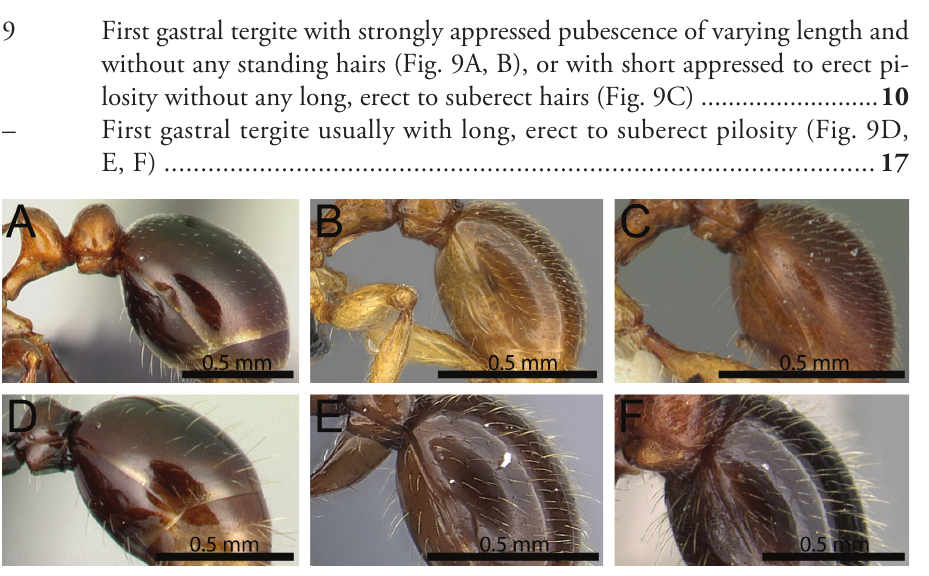
Figure 9. First gastral tergite in profile. A T. wardi (CASENT0475483) B T. cognatum (CASENT0067891) C T. naganum (CASENT0102345) D T. silvicola (CASENT0042828) E T. alperti (CASENT0042547) F T. hobbit